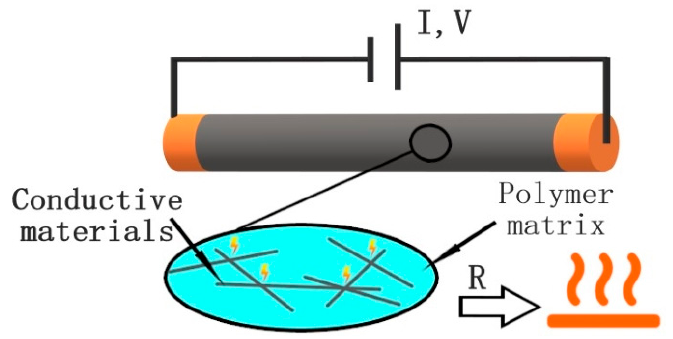
Figure 1. Schematic of Joule heating